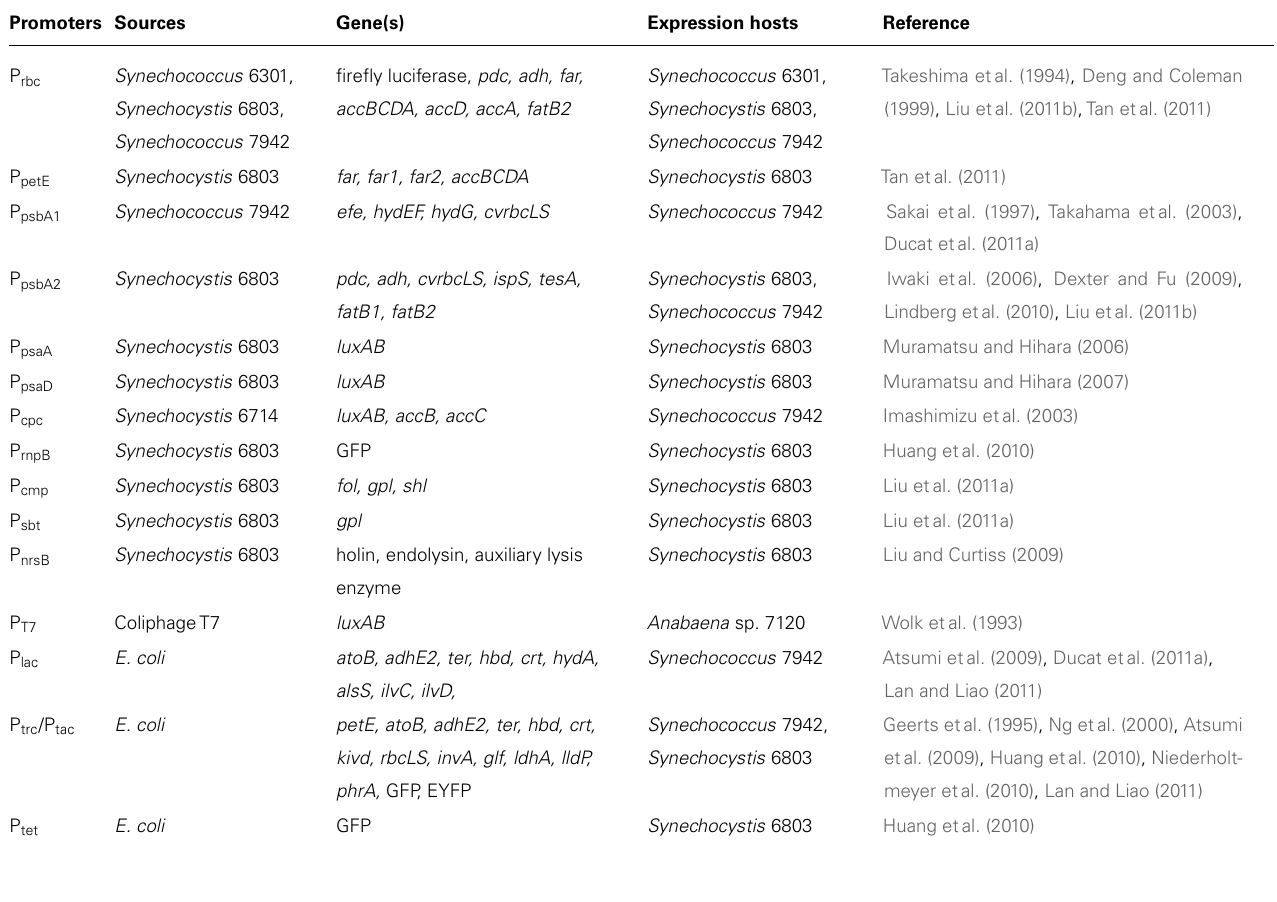
Table 1 | Selected promoters used in cyanobacteria. Promoters